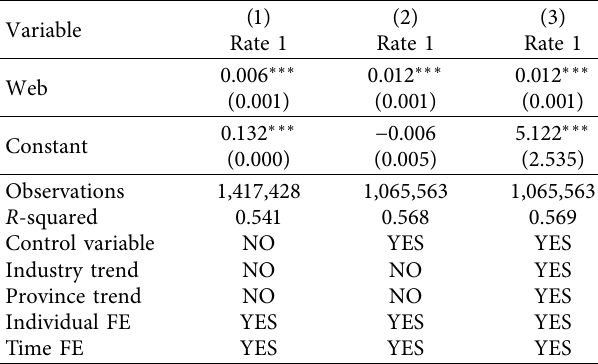
Table 5: Benchmark